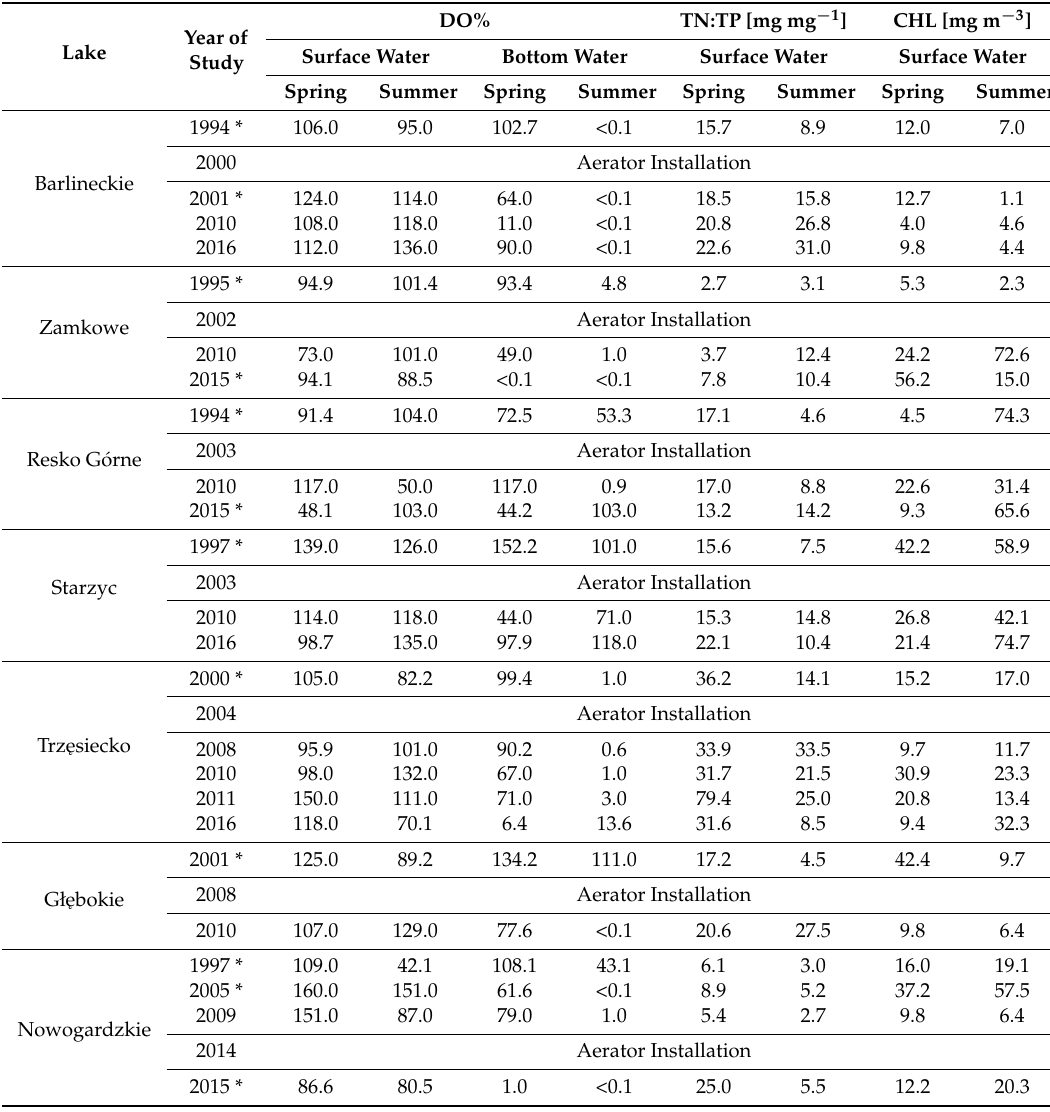
Table 2. The year of the aerator installation and mean values of dissolved oxygen saturation, TN:TP ratio for the analysed lakes in the spring and the summer season during the study years (superscript * means that only one measurement was done per season in this